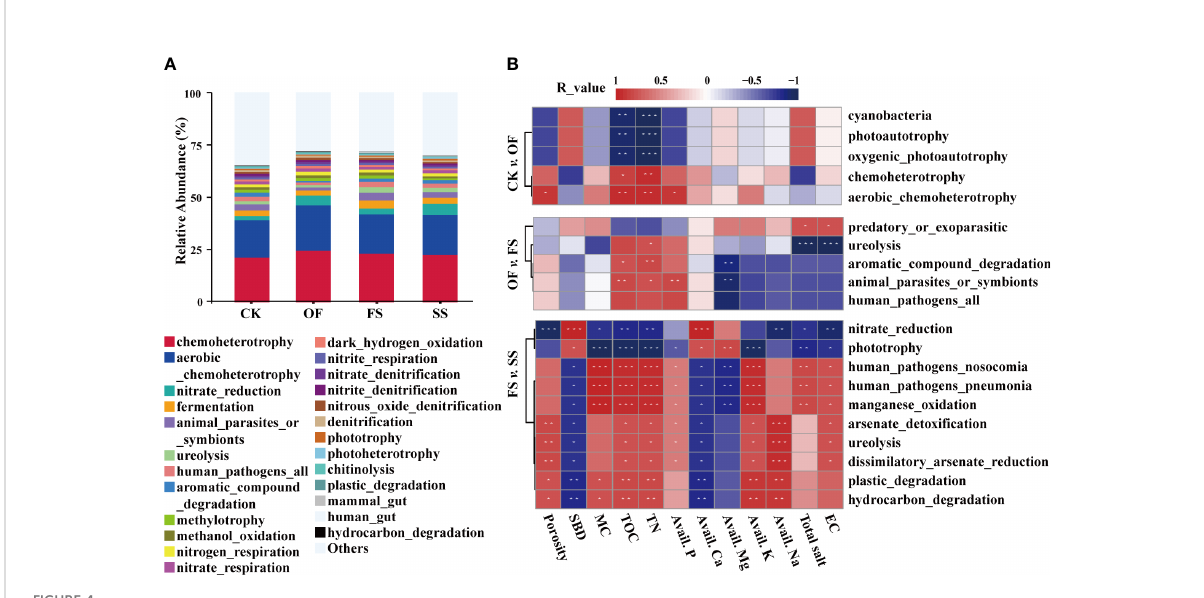
FIGURE 4 (A) Histogram of relative abundance of TOP-20 predicted function of bacterial community in different samples based on FAPROTAX; (B) Spearman correlation analysis between bacterial predicted function and environmental factors with signi fi cant differences among different samples ( “ * ” denotes a P -value< 0.1, “ ** ” denotes a P -value< 0.05, “ *** ” denotes a P -value<